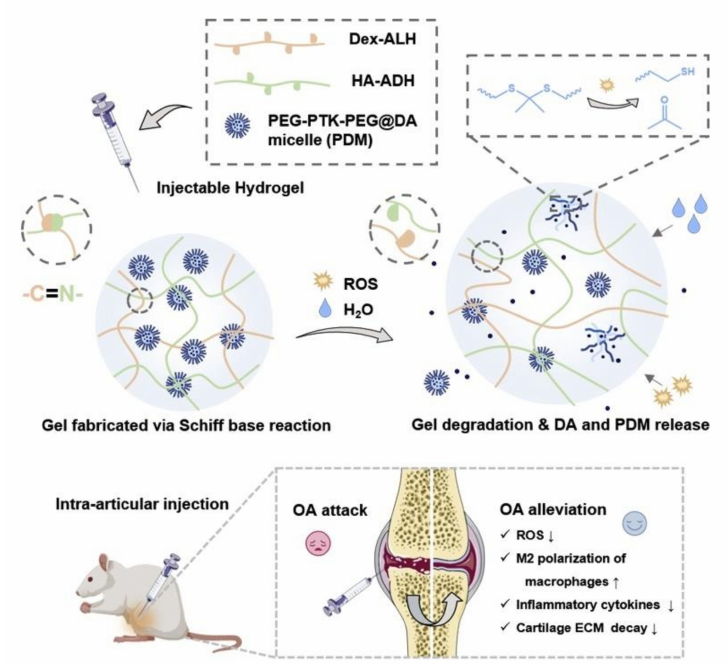
Figure 4. Schematic diagram showing the fabrication of hyaluronic (HA) and dextran (Dex) Schiff base hydrogel loaded with dexamethasone acetate (DA)-encapsulated PEG-PTK-PEG micelles (PDM) for osteoarthritis (OA) therapy in vivo. The hydrogel is swollen and/or degraded in OA joint, allowing the easier reaction between the PDM and ROS to release DA. They synergistically reduce the ROS concentration, upregulate the M2 polarization, downregulate the key inflammatory cytokines, and thereby achieve better therapy of OA in vivo [71]. Reproduced with permission from Zhou, T, Mater. Today Nano; published by Elsevier,